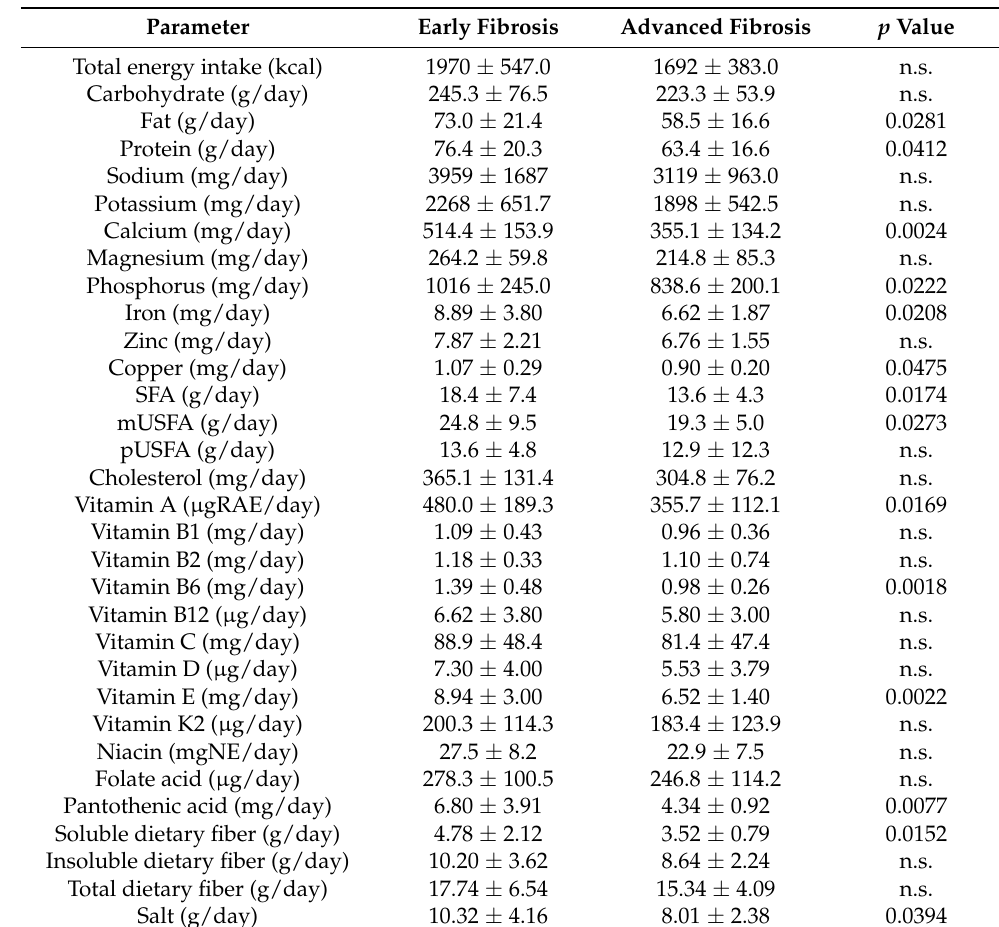
Table 5. Comparison of nutrient intake data (early fibrosis NAFLD group, advanced fibrosis NAFLD